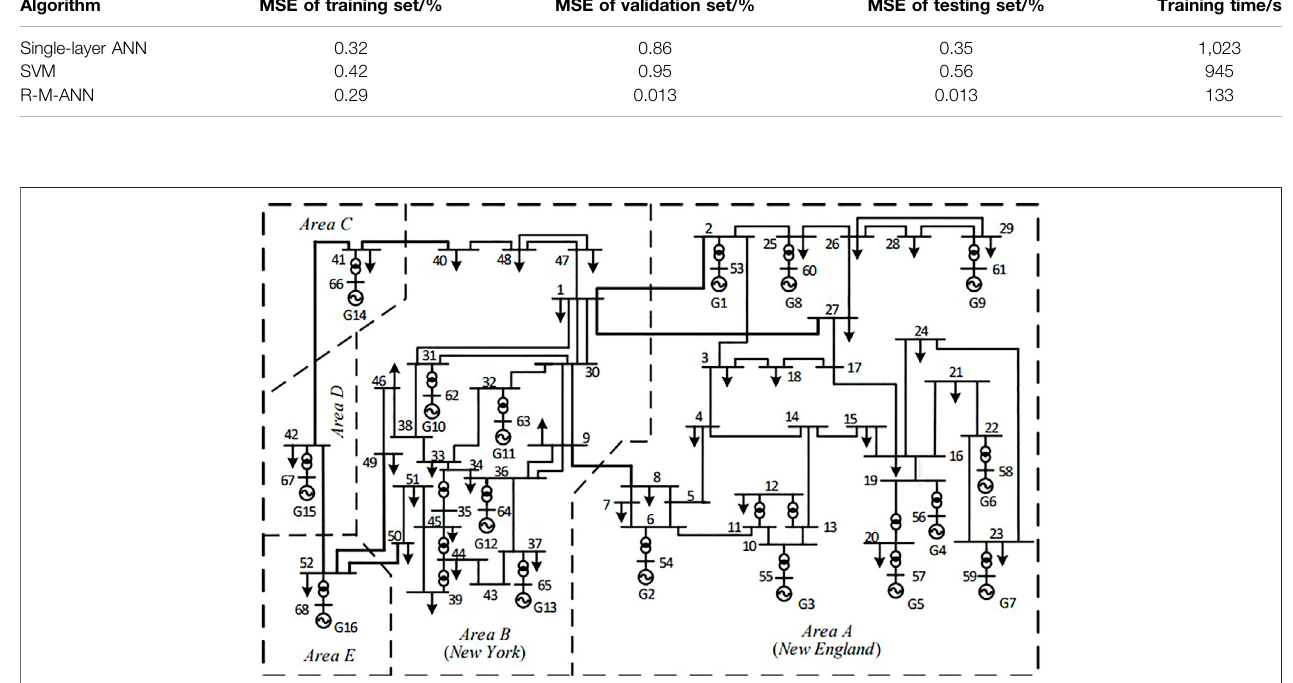
FIGURE 6 | Single-line diagram for the 16-generator 5-area power system.